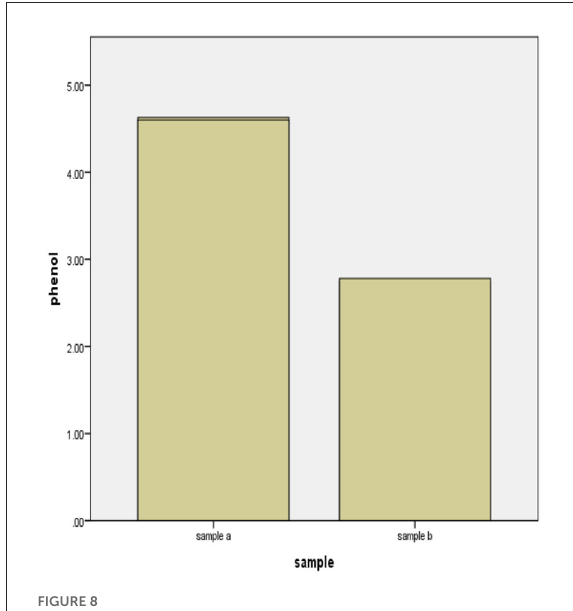
FIGURE8 Phenol content of fermented and unfermented cocoa.